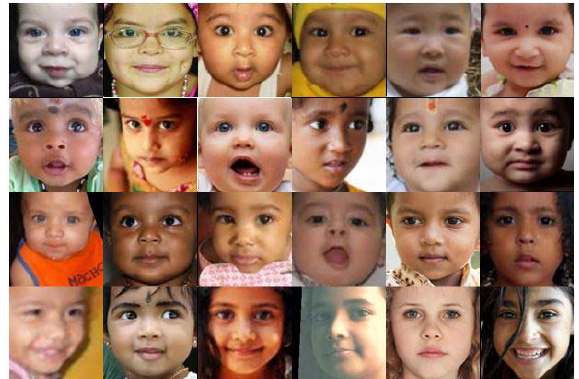
Figure 3. Wiki Sample